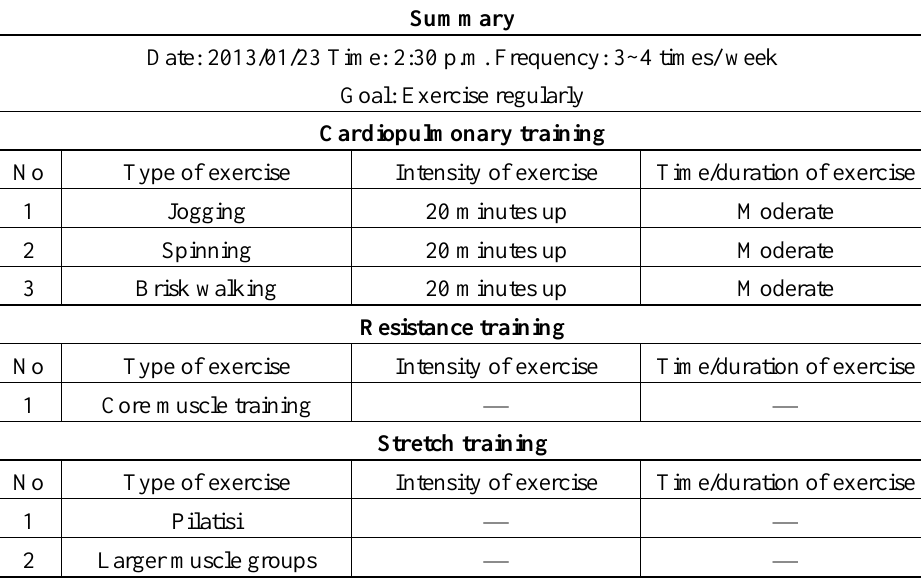
Table 8. Manually-generated personalized exercise plan (Plan A).